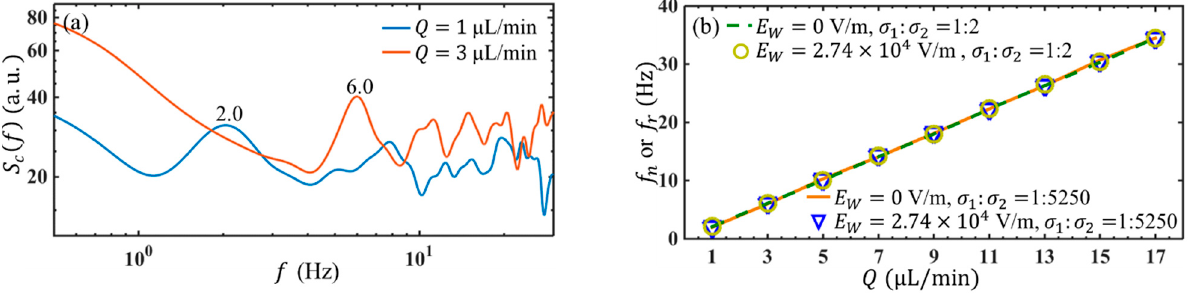
Figure 9. ( a ) 𝑆 (cid:3030) (𝑓) of the unforced flow at different flow rates and the conductivity, the ratio is 1:5250. ( b ) 𝑓 (cid:3045) vs. 𝑄 at different 𝐸 (cid:3024) for conductivity ratios of 1:2 and 1:5250, where 𝑓 (cid:3033) = 130